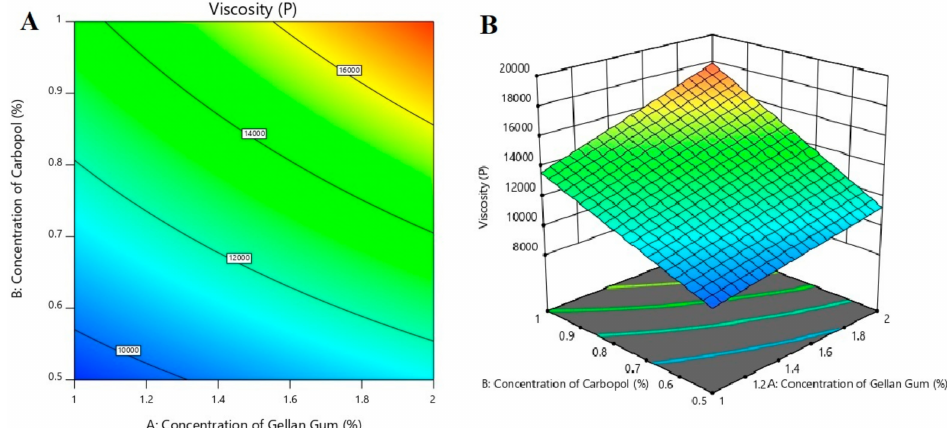
Figure 3. E ff ect of independent variables on viscosity using contour plot ( A ) and 3d response surface plot ( B